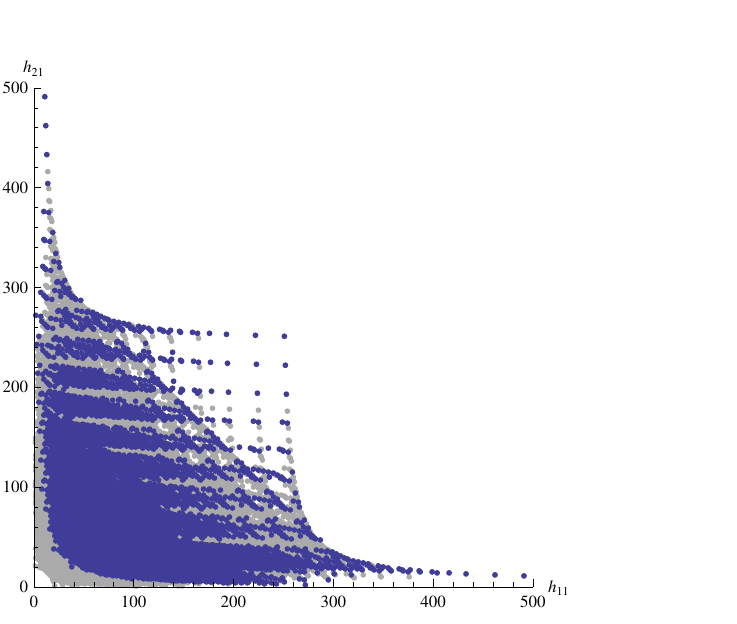
Figure 1 . The Hodge numbers (blue points) of Calabi-Yau threefolds X formed as generic elliptic (cid:12)brations over toric base surfaces. All these examples have a particularly simple form of factorized mirror symmetry in which X and ~ X both have elliptic (cid:12)bers described as anti-canonical curves in the toric (cid:12)ber F 10 = P 2 ; 3 ; 1 and the mirror base ~ B is constructed as a toric variety from the monomials in the line bundle O ( (cid:0) 6 K B ), where B is the base of the elliptic (cid:12)bration of X . Gray points are Hodge numbers in the full KS